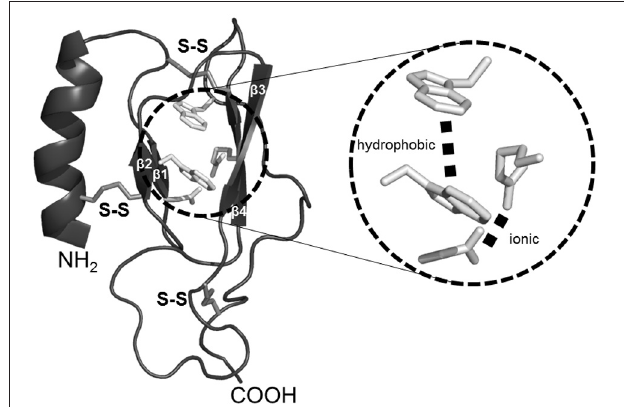
FIGURE 1 | Representation of generic Sushi domain core of Class B GPCR N-ted. Common structural elements of class B GPCR N-ted are represented by the presence of (1) a N-terminal α -helix ( black ribbon); (2) two anti-parallel β -sheets ( β 1- β 2 and β 3- β 4, black ribbon). The Sushi domain structural core is stabilized by the presence of three conserved disulfide bonds ( middle gray sticks) and represented in magnified inset an ionic and hydrophobicinteractions ( light gray sticks). All figures were obtained by using PyMOL software